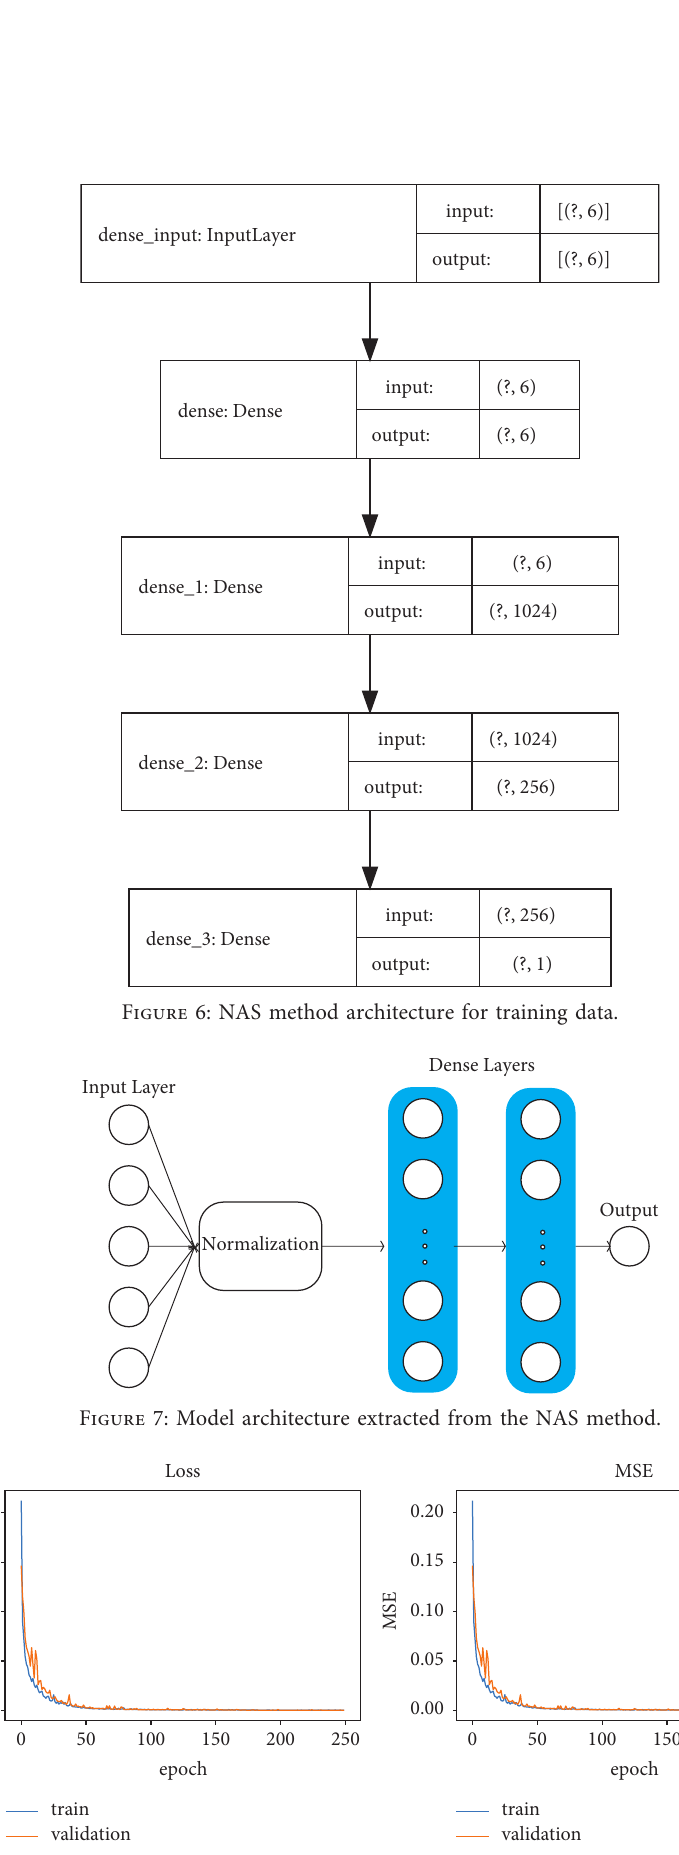
Figure 8: Criteria for errors in the deep learning